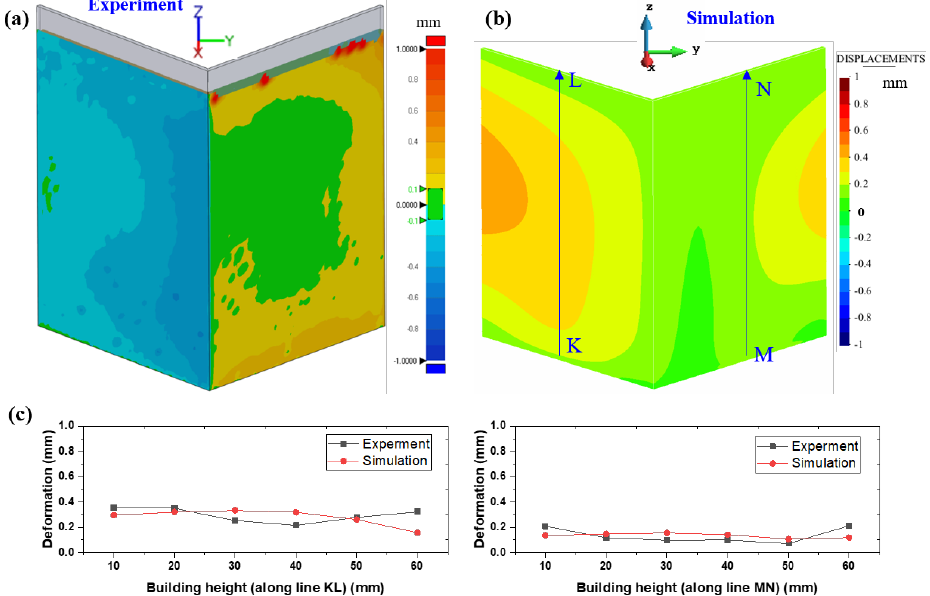
Figure 10. L − shape (L1) part: comparison between the ( a ) experimental and ( b ) simulated displace- ment distributions. ( c ) The deformation distribution along the lines KL and MN, which are located at the center of the two outer surfaces of the build, respectively. The negative value of the displacements in the experimental results means that the distortion is towards the inside of the CAD geometry.